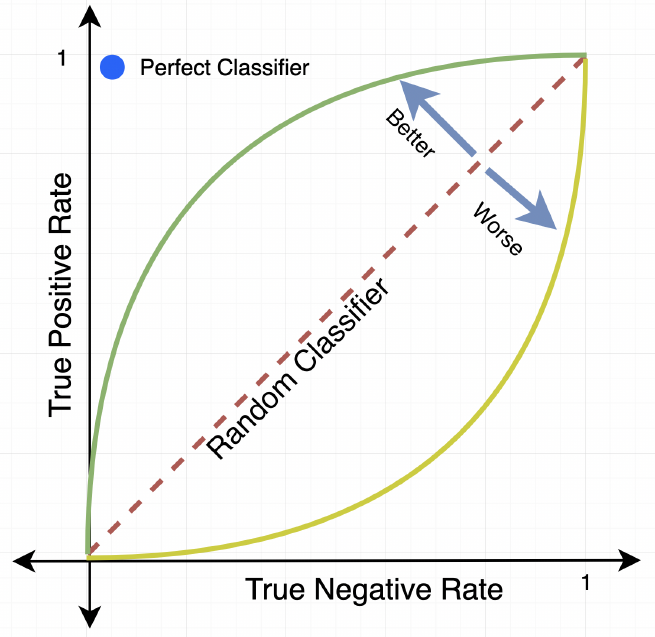
Figure 24. ROC curve